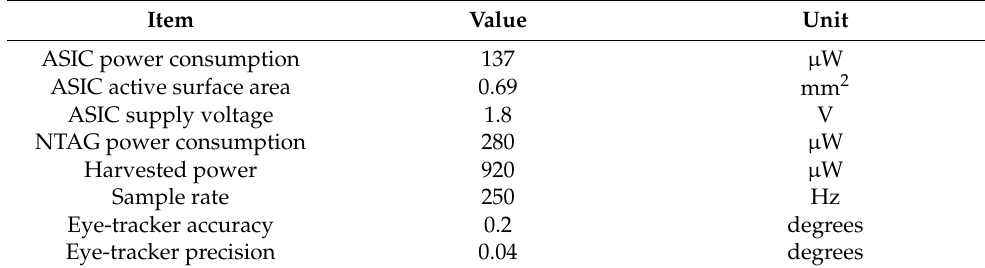
Table 1. Eye-tracker main features and performances.